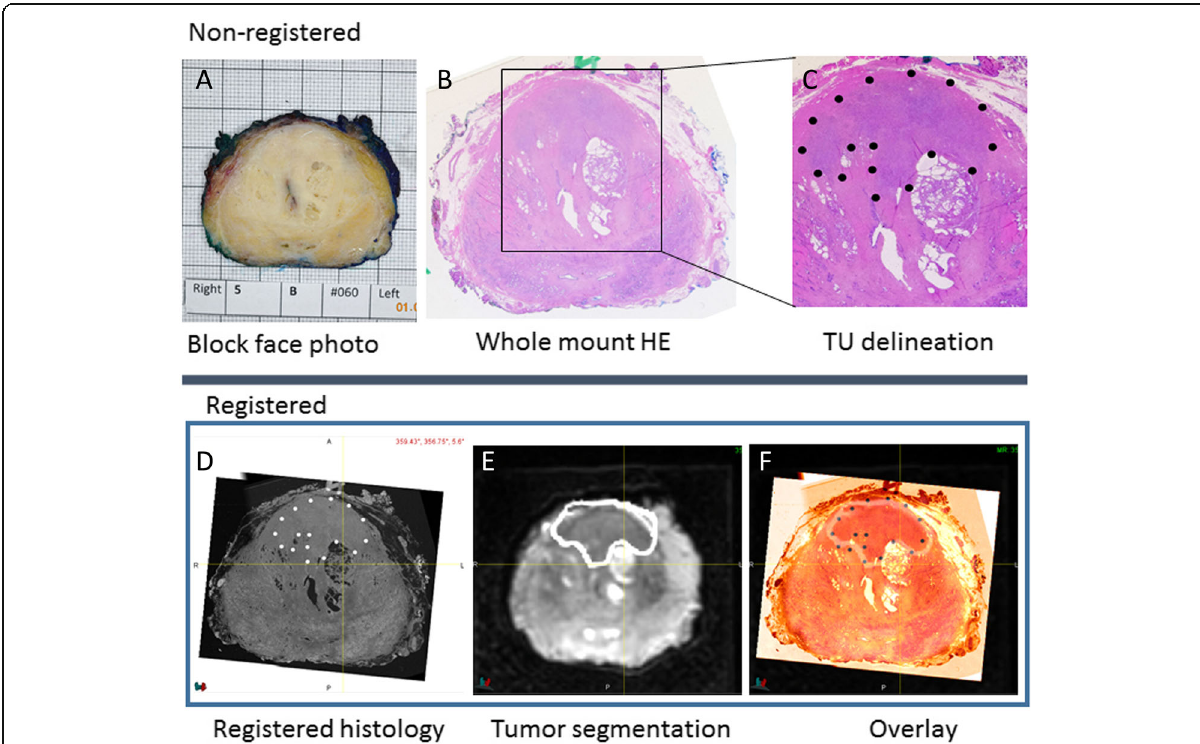
Fig. 2 Registration process step 2. Individual sections of the specimen were photographed ( a ) and whole-mount sectioned for HE histology ( b ). The tumor borders were marked by the pathologist ( c ). Stacked histology slices ( d ) were registered to the mold MRI scan ( e ). Registration accuracy can be checked on overlay images ( f